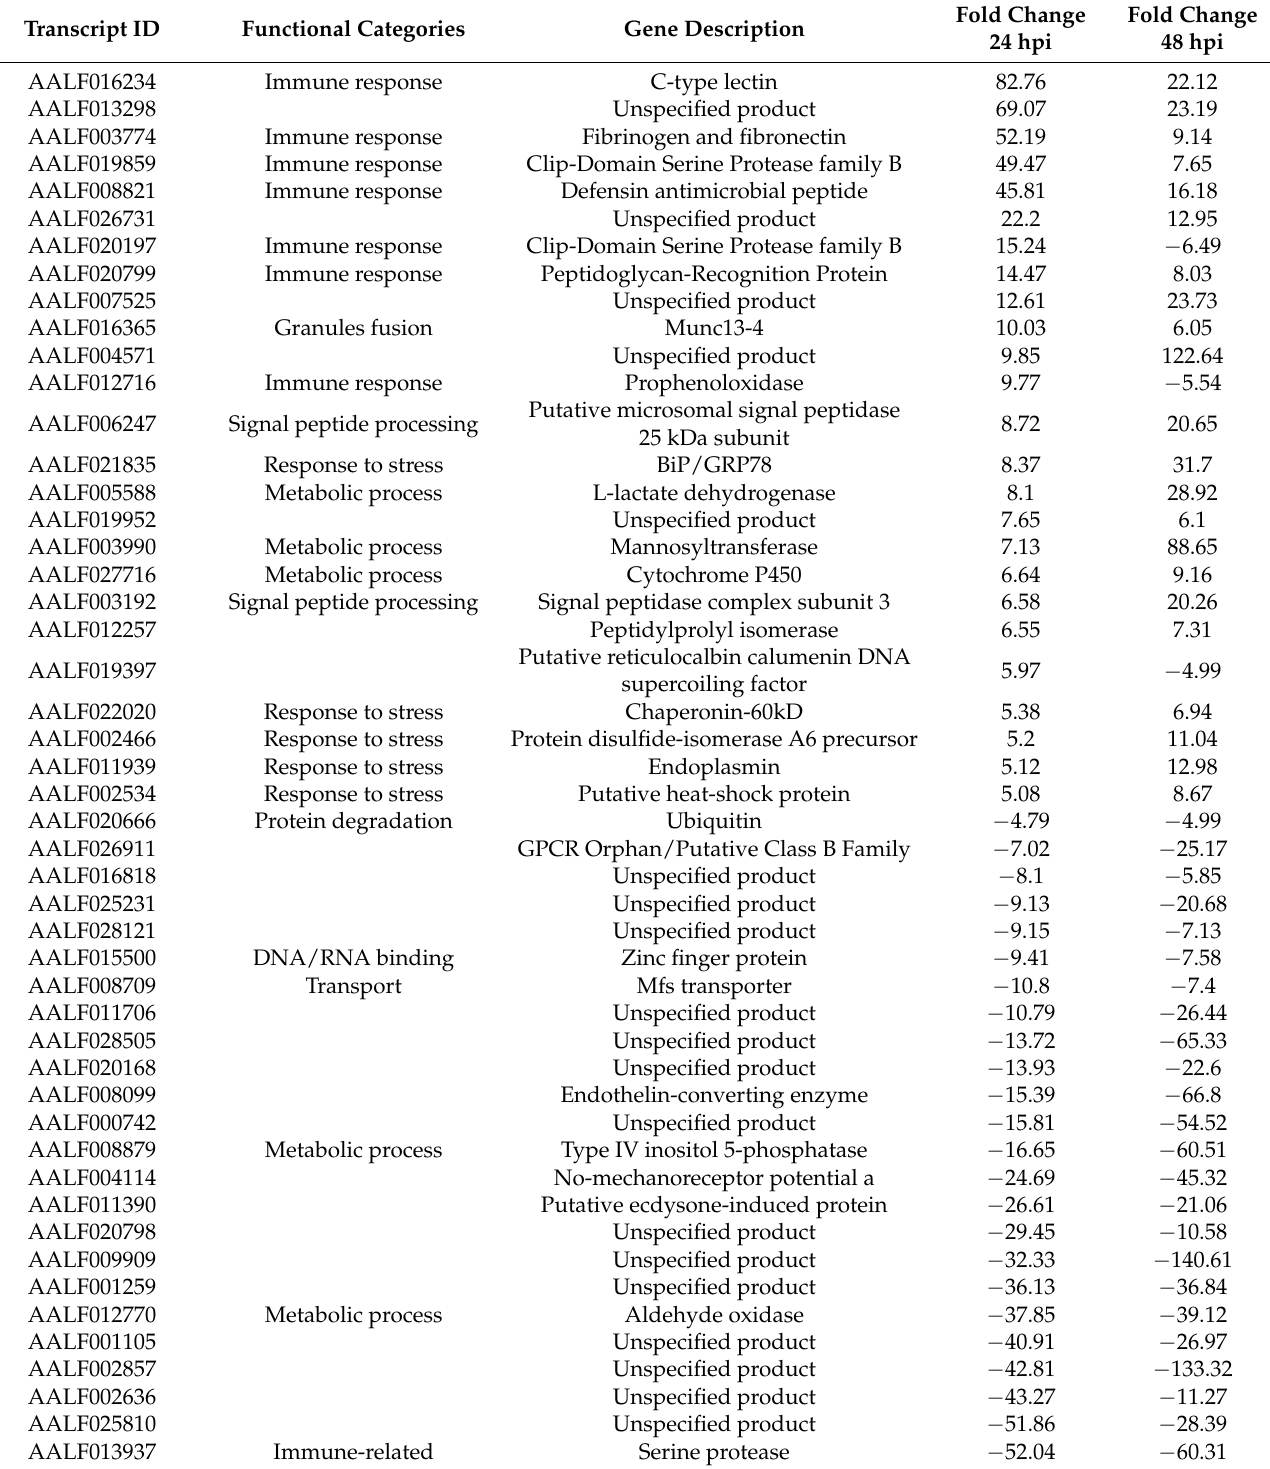
Table 2. List of Ae. albopictus overlapping differentially expressed transcripts following LamV infection and WNV challenge. Functional categories are based on GO terms for biological processes. Fold changes are shown in hours post-challenge with WNV. The cut-offs used were p -adjusted value of ≤ 0.01 and log 2 FC of ≥